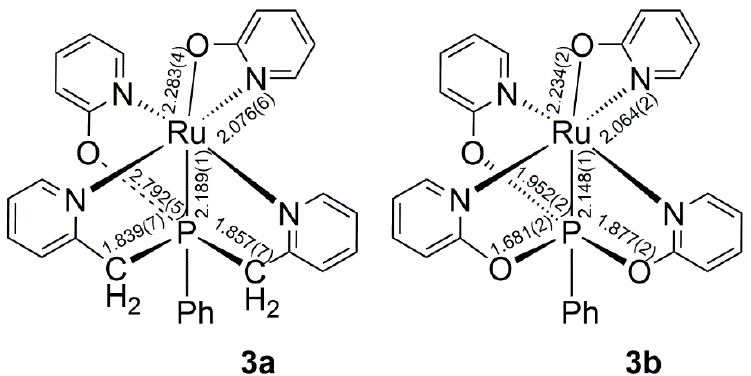
Figure 2. Comparison of corresponding interatomic separations (Å) in the molecular structures of 3a (the molecule shown in Figure 1) and 3b [4].